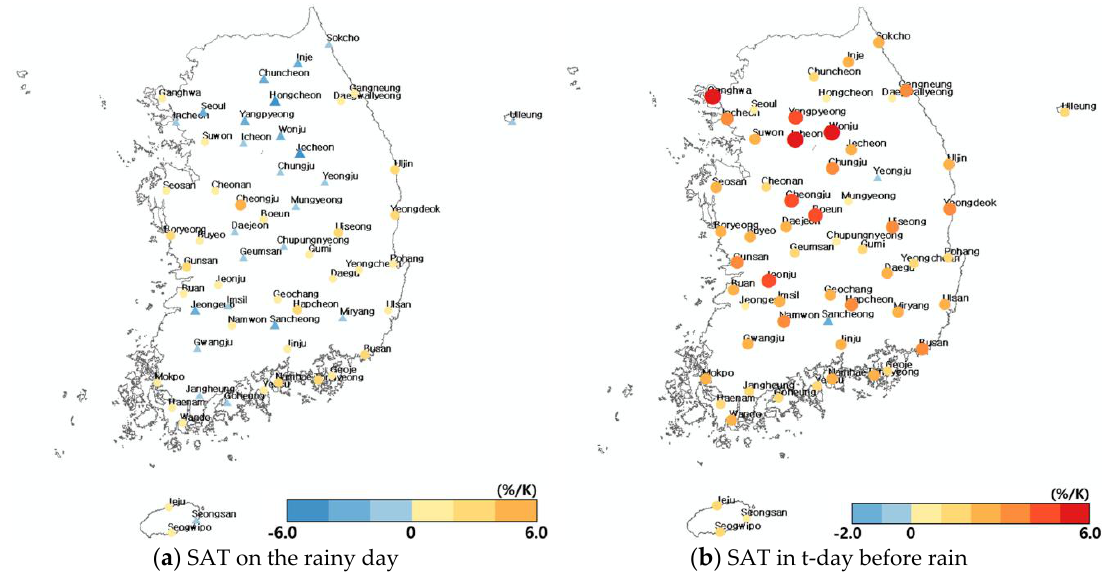
Figure 6. Sensitivity of annual exceedance daily rainfall depth to SAT in all sites.